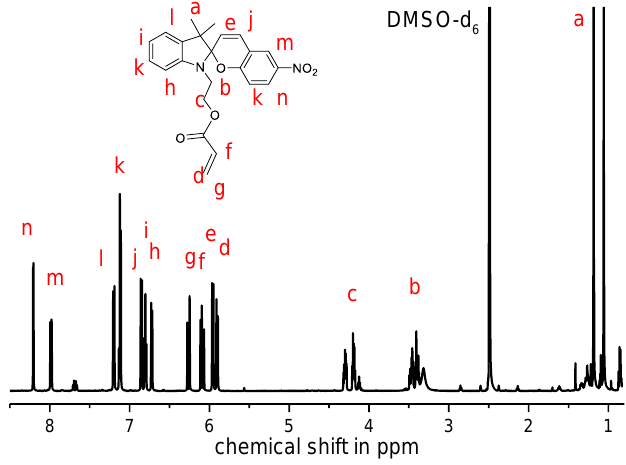
Figure 1. 1 H-NMR spectrum of SPA in DMSO-d 6 .